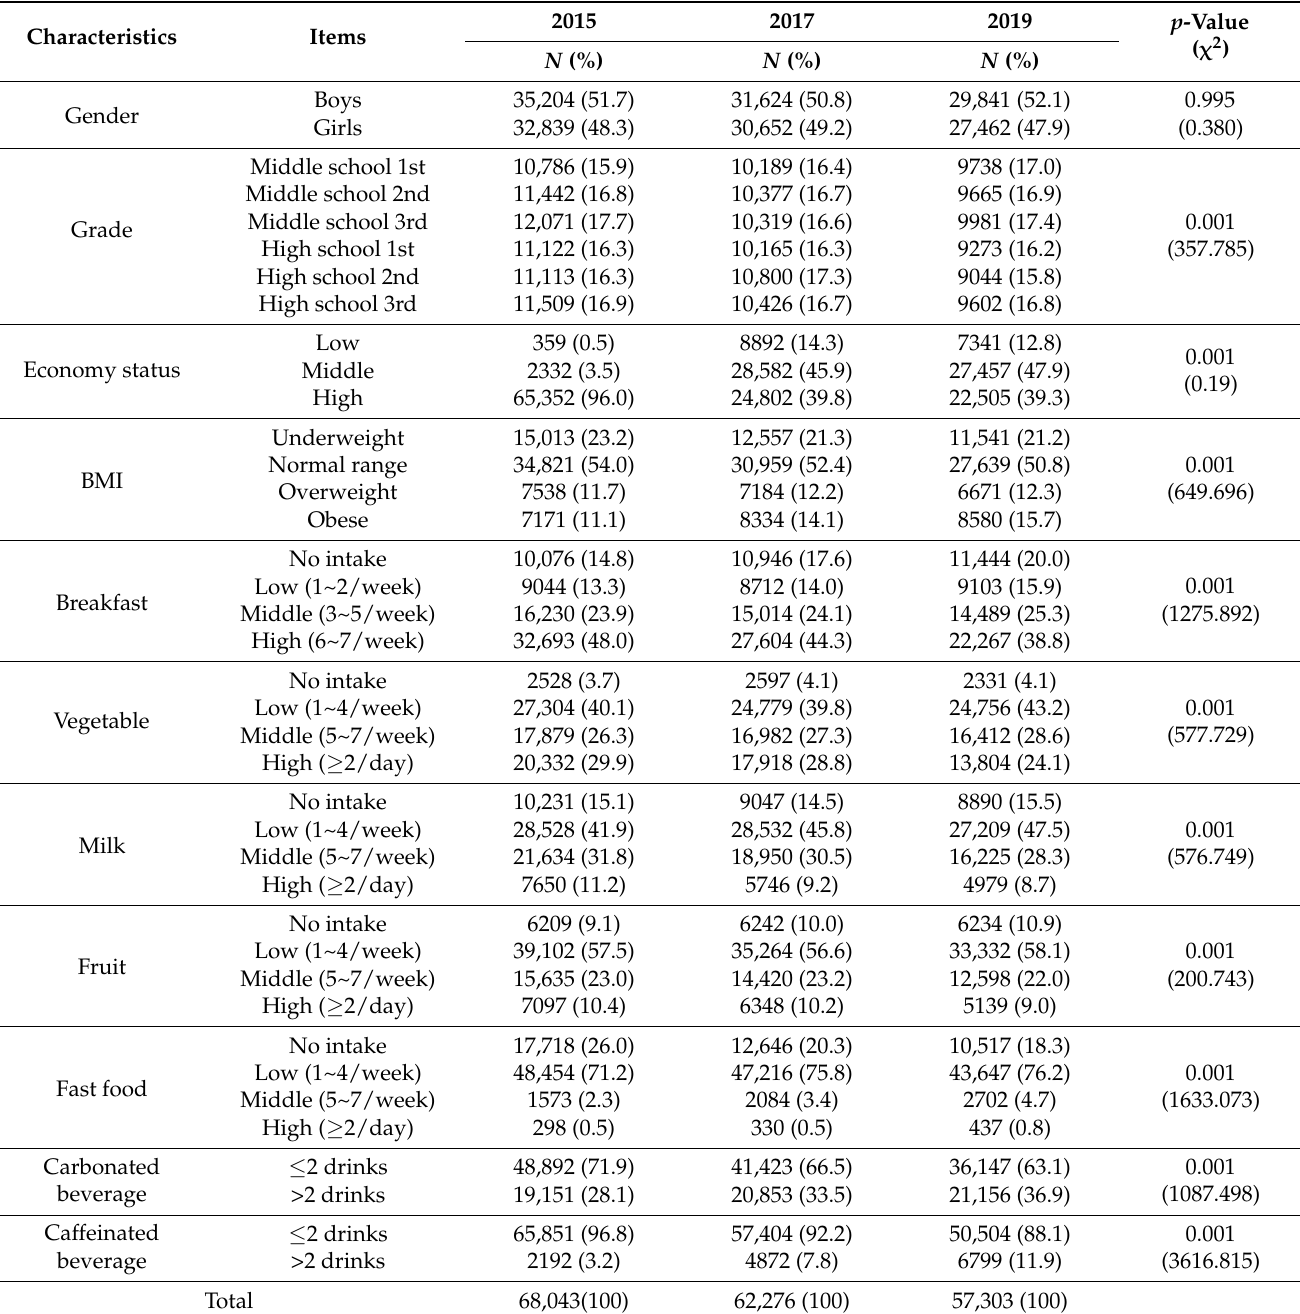
Table 2. General characteristics of adolescents ( N =